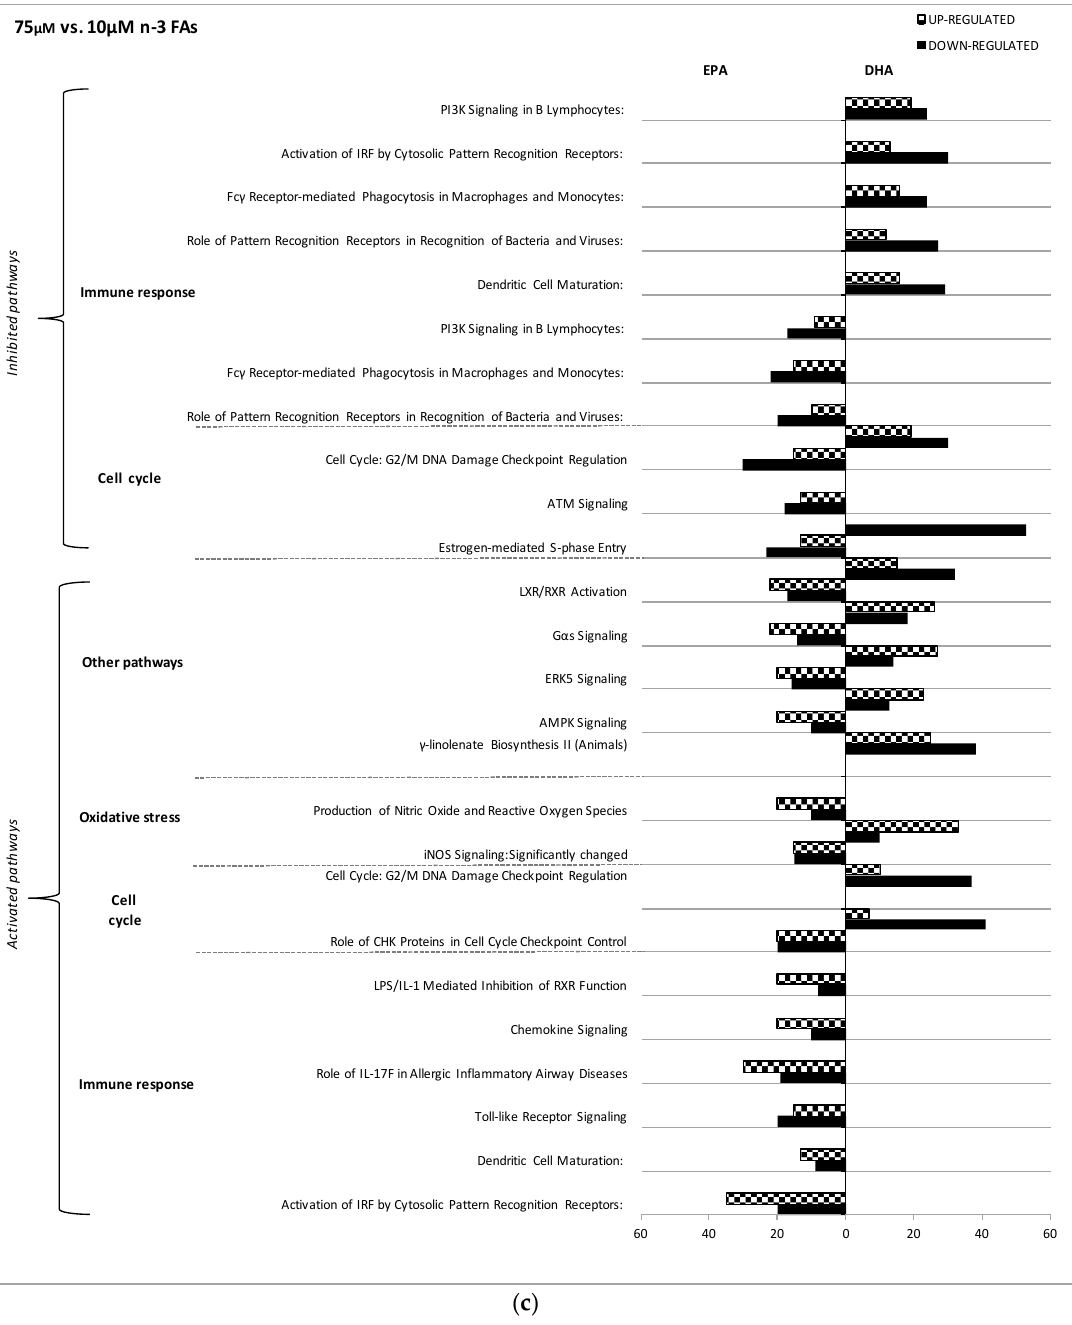
Figure 4. Impact of EPA and DHA dose reduction on canonical pathways in LPS-stimulated macrophages. The effect of EPA and DHA dose reduction (75 µM versus 50 µM, 75 µM versus 50 µM and 75 µM versus 10 µM) on gene regulation in LPS-stimulated macrophages is shown (( A – C ), respectively). Differentially expressed genes are organized in canonical pathways regrouped into different families ( immune response , apoptosis , cellular cycle , oxidative stress and other pathways ). The amount of up- and down-regulated genes within each pathway is also shown (horizontal grey and black bars, respectively). PPAR: Peroxisome Proliferator-Activated Receptor, AMPK: AMP-Activated Protein Kinase, RIG1: RIG-I-like Receptor, INOS: Inductible Nitric Oxide Synthase, CD40: Cluster of Differentiation 40, IRF: Interferon Regulatory Factor, PI3K: Phosphoinositide 3-kinase, Fc gamma: Fc-Gamma Receptor, CHK: Checkpoint kinase.